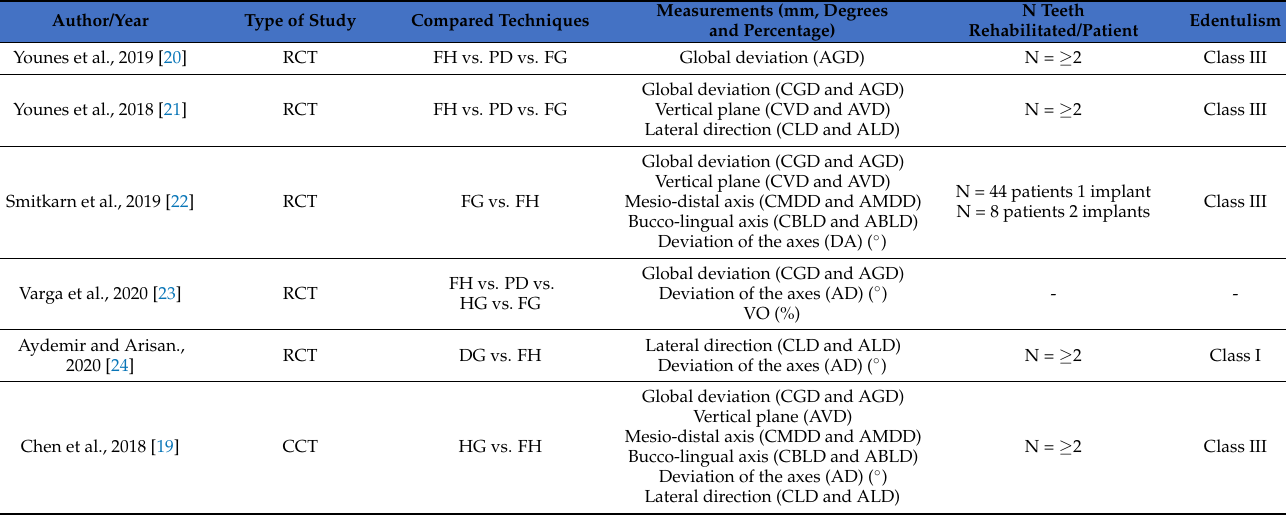
Table 2. Data collected from the studies.